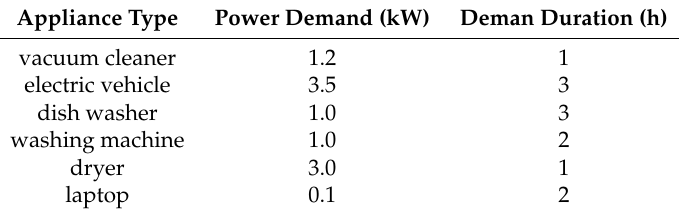
Table 2. Information of Shiftable Loads [26].